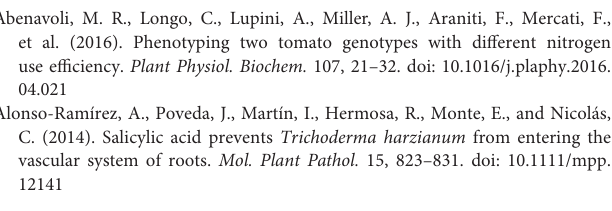
TABLE S6 | Physiological processes differentially affected in wheat seedling roots in response to the combined application of Trichoderma harzianum T34 and